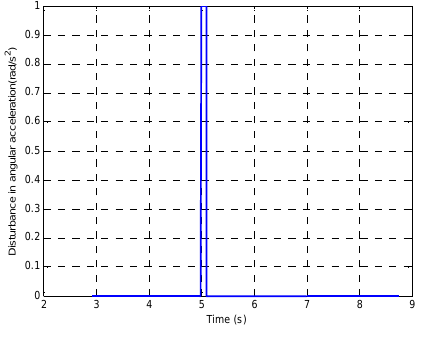
Fig.4. Disturbance in angular acceleration